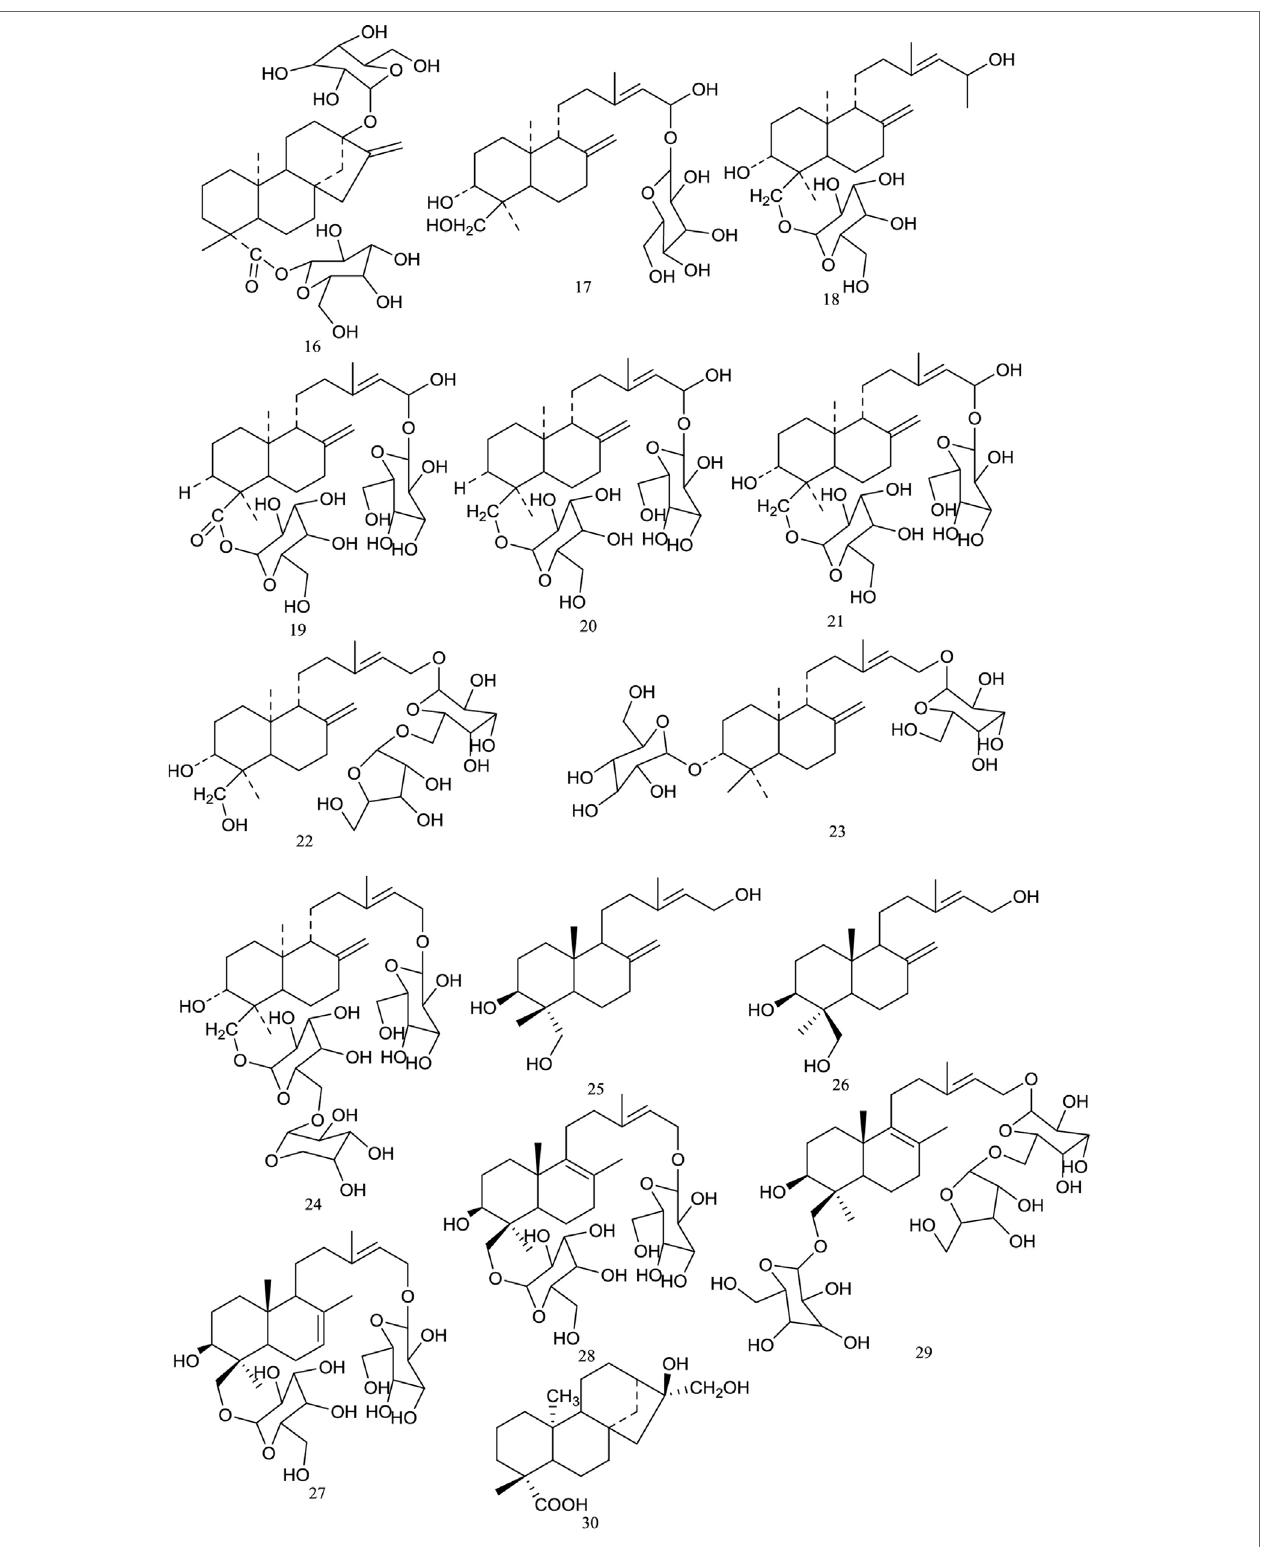
FIGURE 2 | Chemical structures of diterpenoids (16–30) isolated from R. chingii